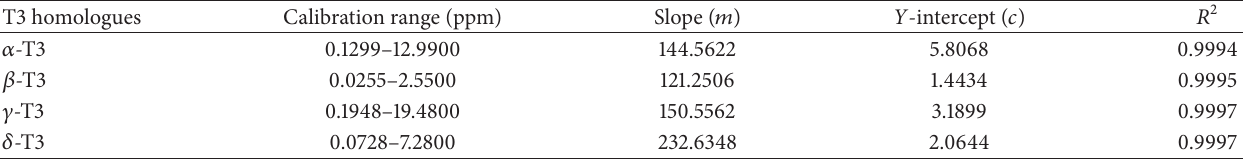
Table 1: Detection range and linear correlation of T3 homologues.